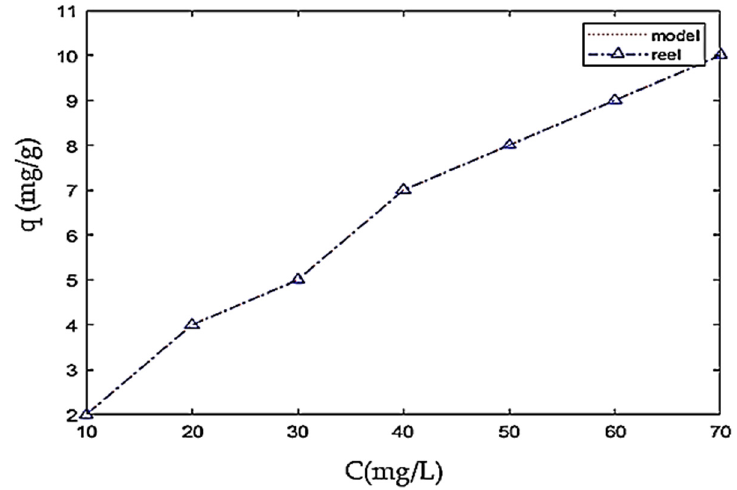
Figure 10. Comparison between the mathematical model and the observed results.